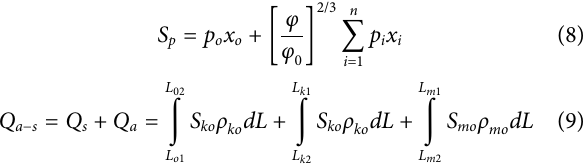
Frontiers in Earth Science |